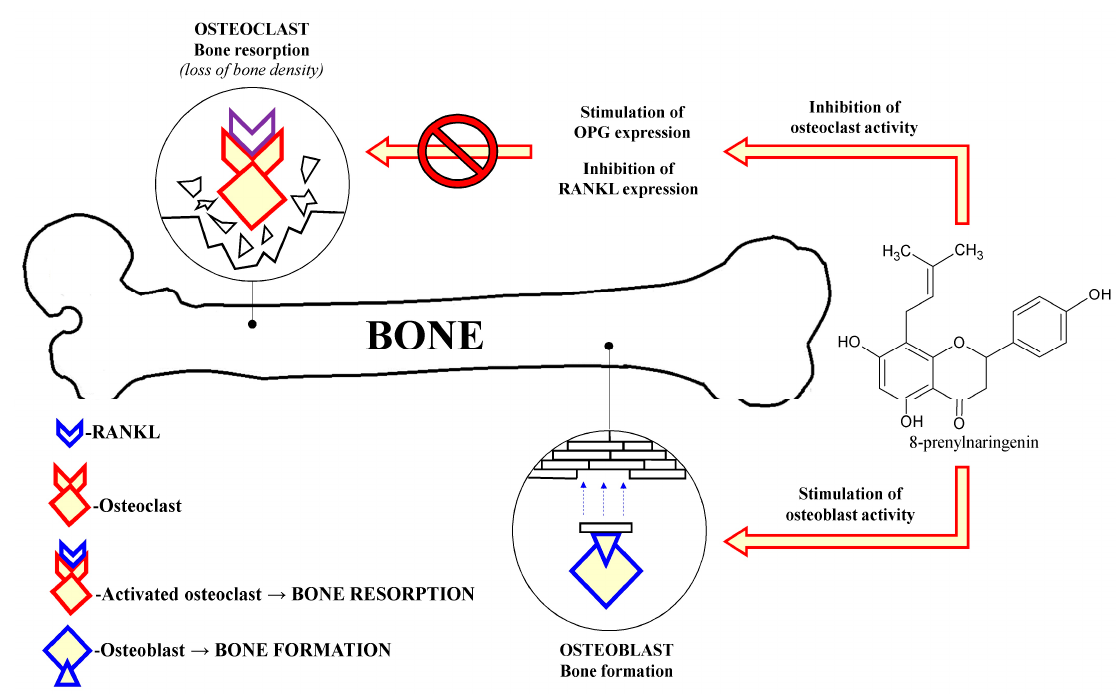
Figure 2. Role of 8-prenylnaringenin (8-PN) in prevention of osteoporosis.